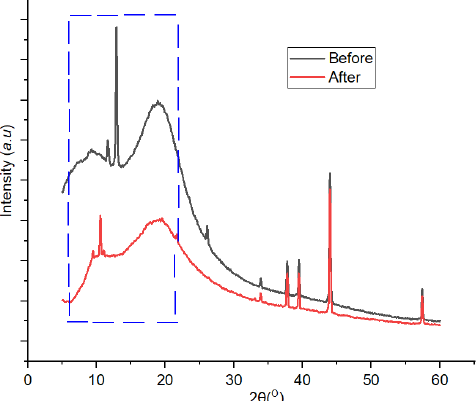
Figure 12. Diffractogram of 1,10-phenanthroline-immobilized PU membranes before and after use for Pb 2+ analysis.